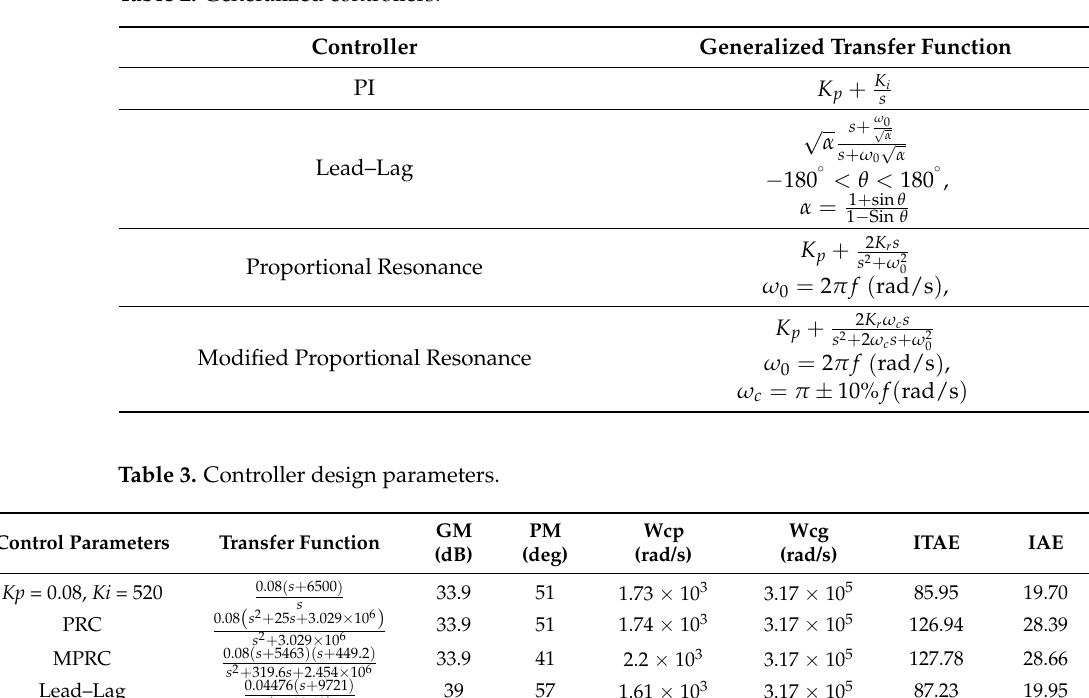
Table 2. Generalized controllers.